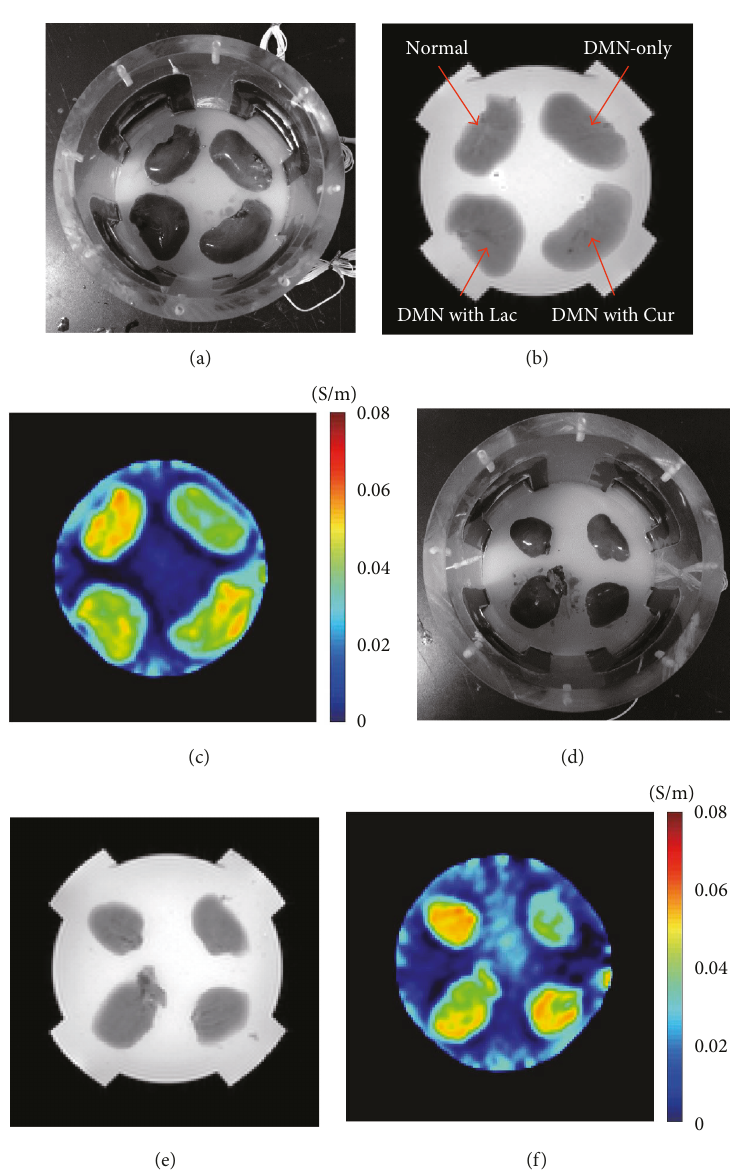
Figure 2: Typical MREIT images of two liver phantoms. (a and d) Phantom consisted of four liver blocks including normal control, DMN- only, DMN with lactulose, and DMN with curcumin. (b and e) MR magnitude images provide morphological information on the liver phantom. (c and f) Electrical conductivity images of liver tissue indicate contrast information depending on their tissue